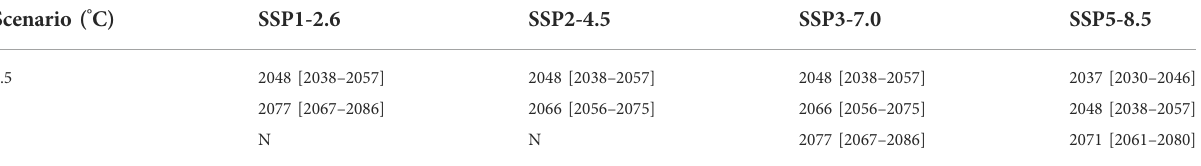
TABLE 4 Period of CMIP6 multi-model ensemble reaching different temperature warming targets from 1986 to 2005. Scenario ( °